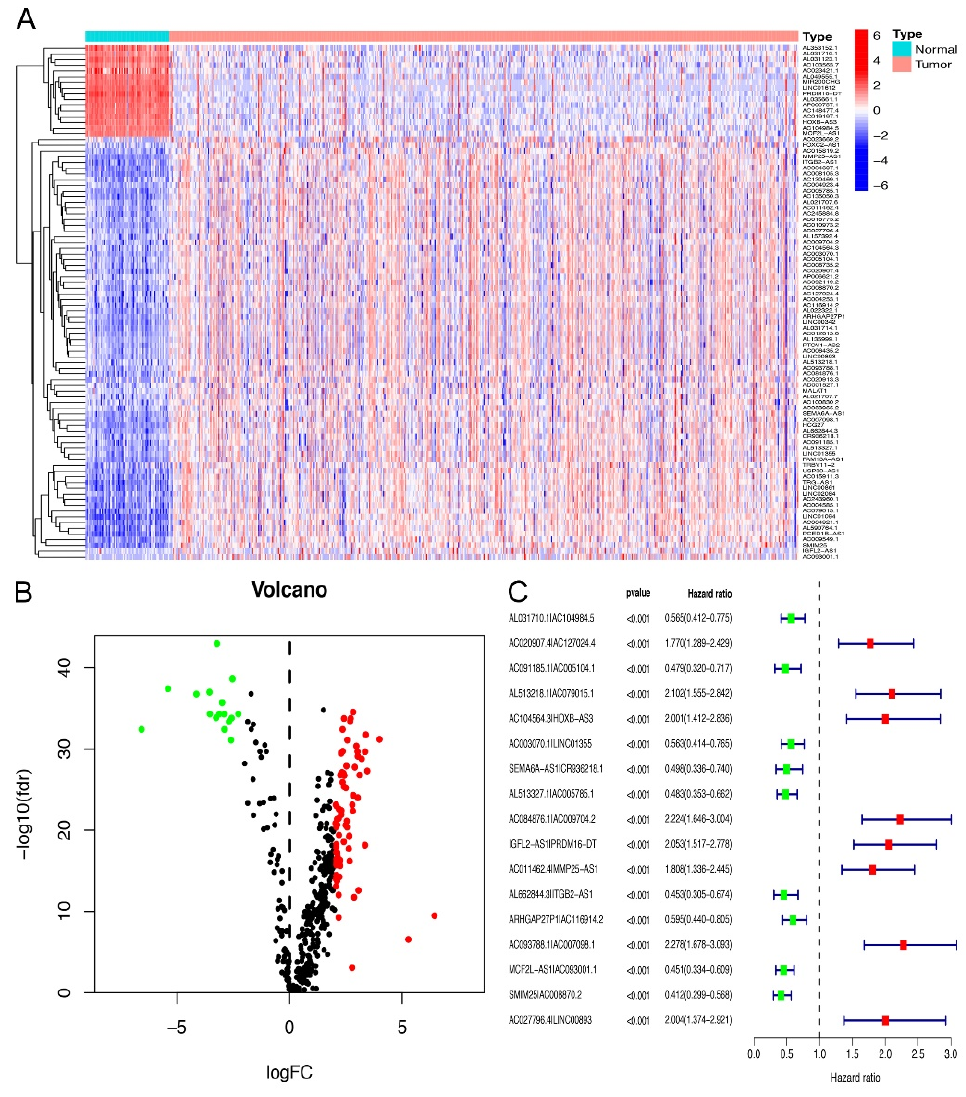
Figure 1. Construction of a risk assessment model using DEirlncRNA pairs. ( A , B ) Heatmap ( A ) and Volcano map ( B ) were drawn according to the DEirlncRNA results. ( C ) The Forest map shows 17 DEirlncRNA pairs determined by Cox regression analysis.